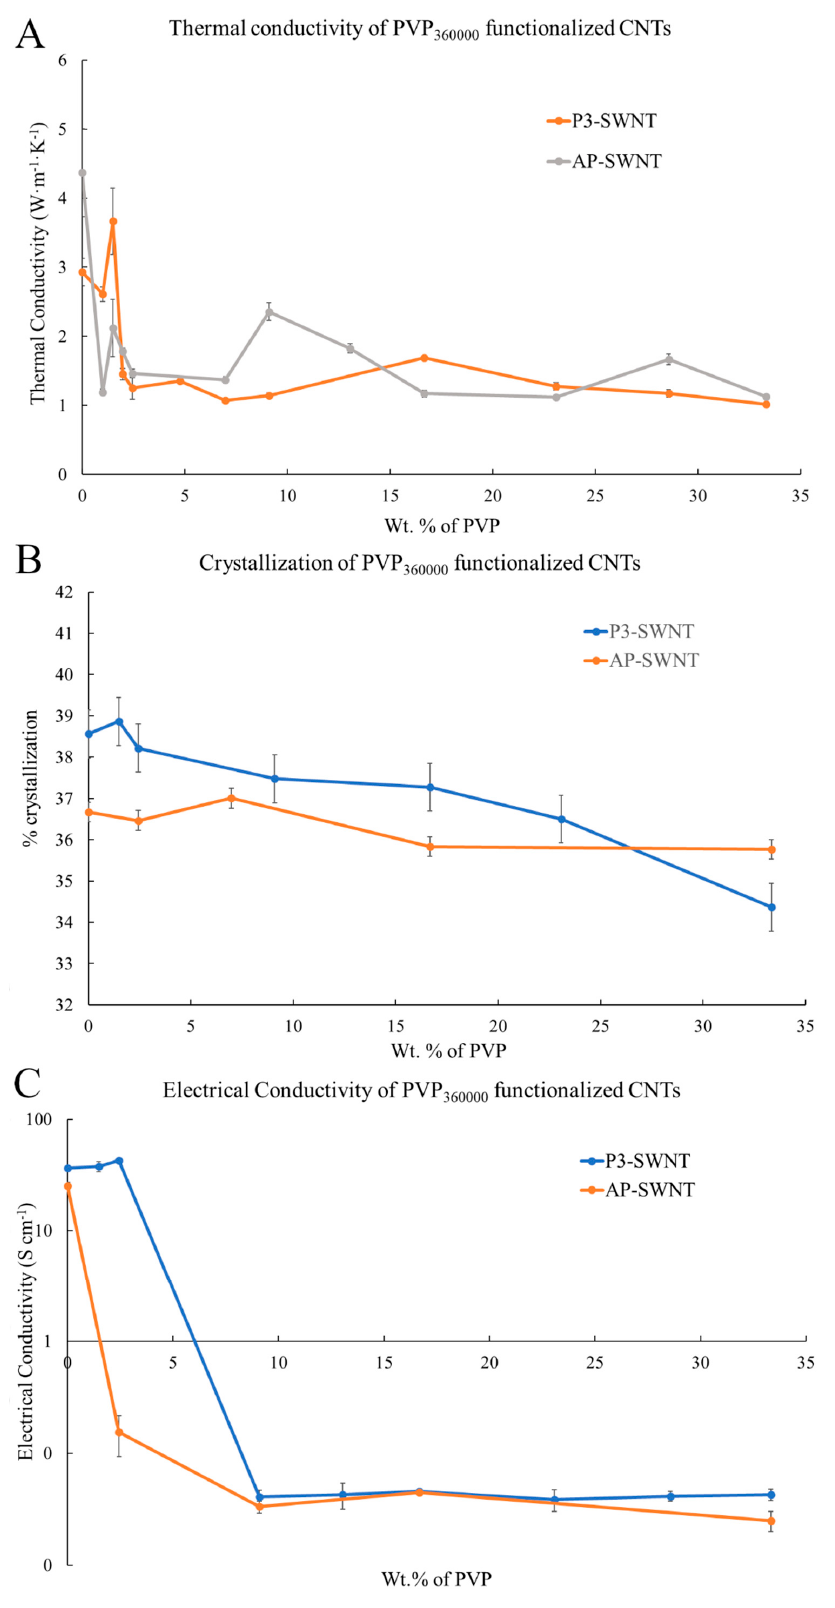
Figure 7. ( A ) Thermal conductivity of two different types of PVP 360000 functionalized CNT/PVDF composites; ( B ) Percent Crystallization; and ( C ) Electrical conductivity of PVP 360000 functionalized CNT/PVDF composites at different PVP